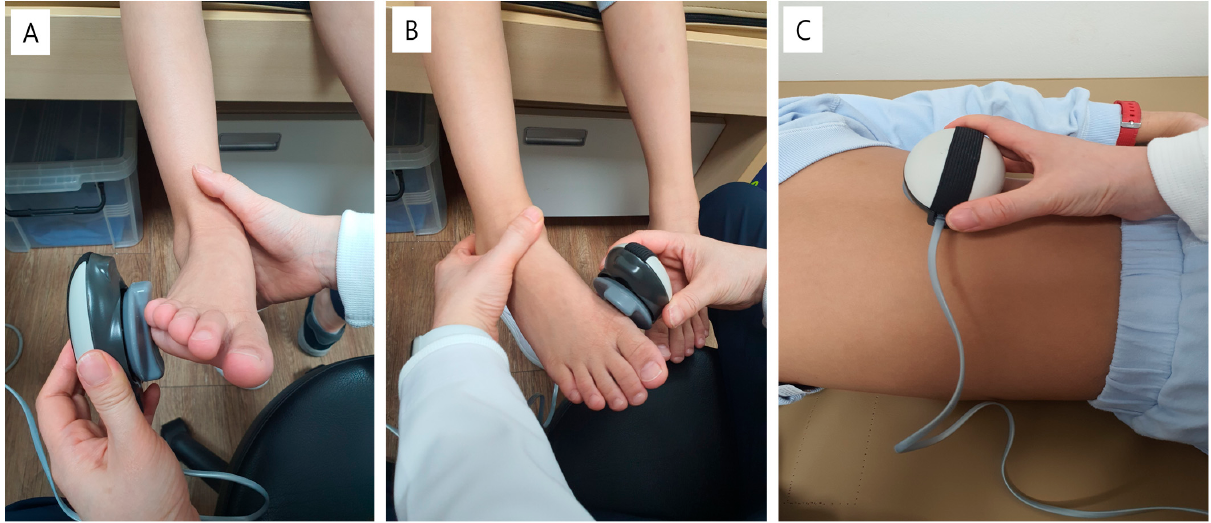
Figure 5. Measurement of isometric strength of ankle evertor ( A ), ankle inverter ( B ), and lumbar extensor ( C ) with a hand-held dynamometer .